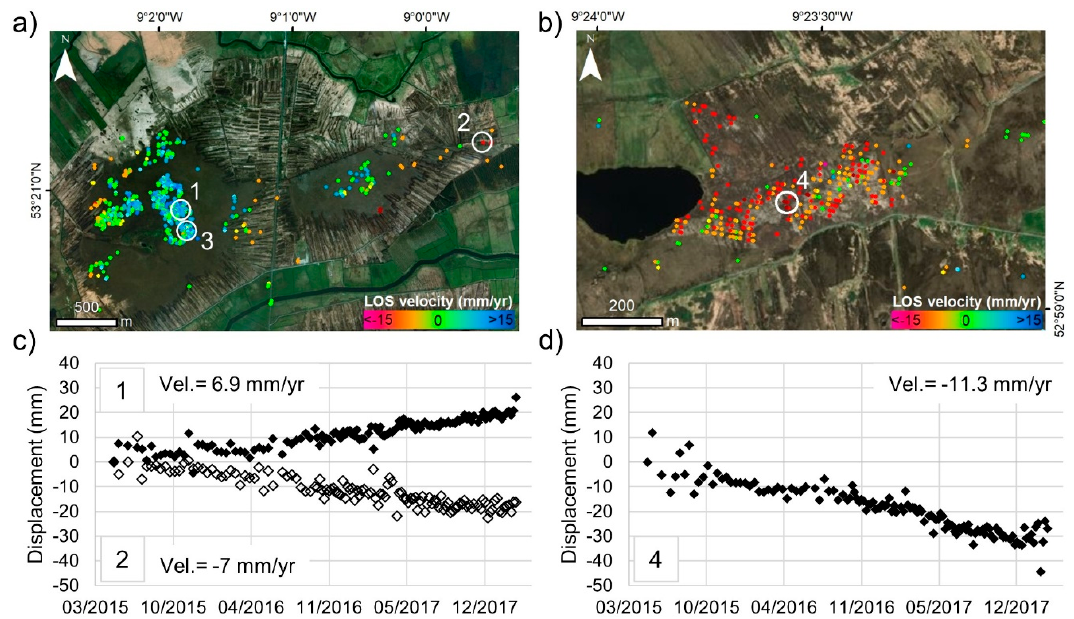
Figure 15. Surface movement detected by PS-InSAR in peatlands in AOI-1. ( a ) Uplift and subsidence movements occurring over a raised peatland, denoted locality ‘f’ in Figure 7. To notice the different behavior of the reported displacements time series extracted (white circle) for the (1) intact (uplift) and (2) harvested (subsidence) peat areas. ( b ) Subsidence occurring in a blanket peatland, denoted locality ‘g’ in Figure 7. The white circle marks the location of the extracted displacement time series (4).